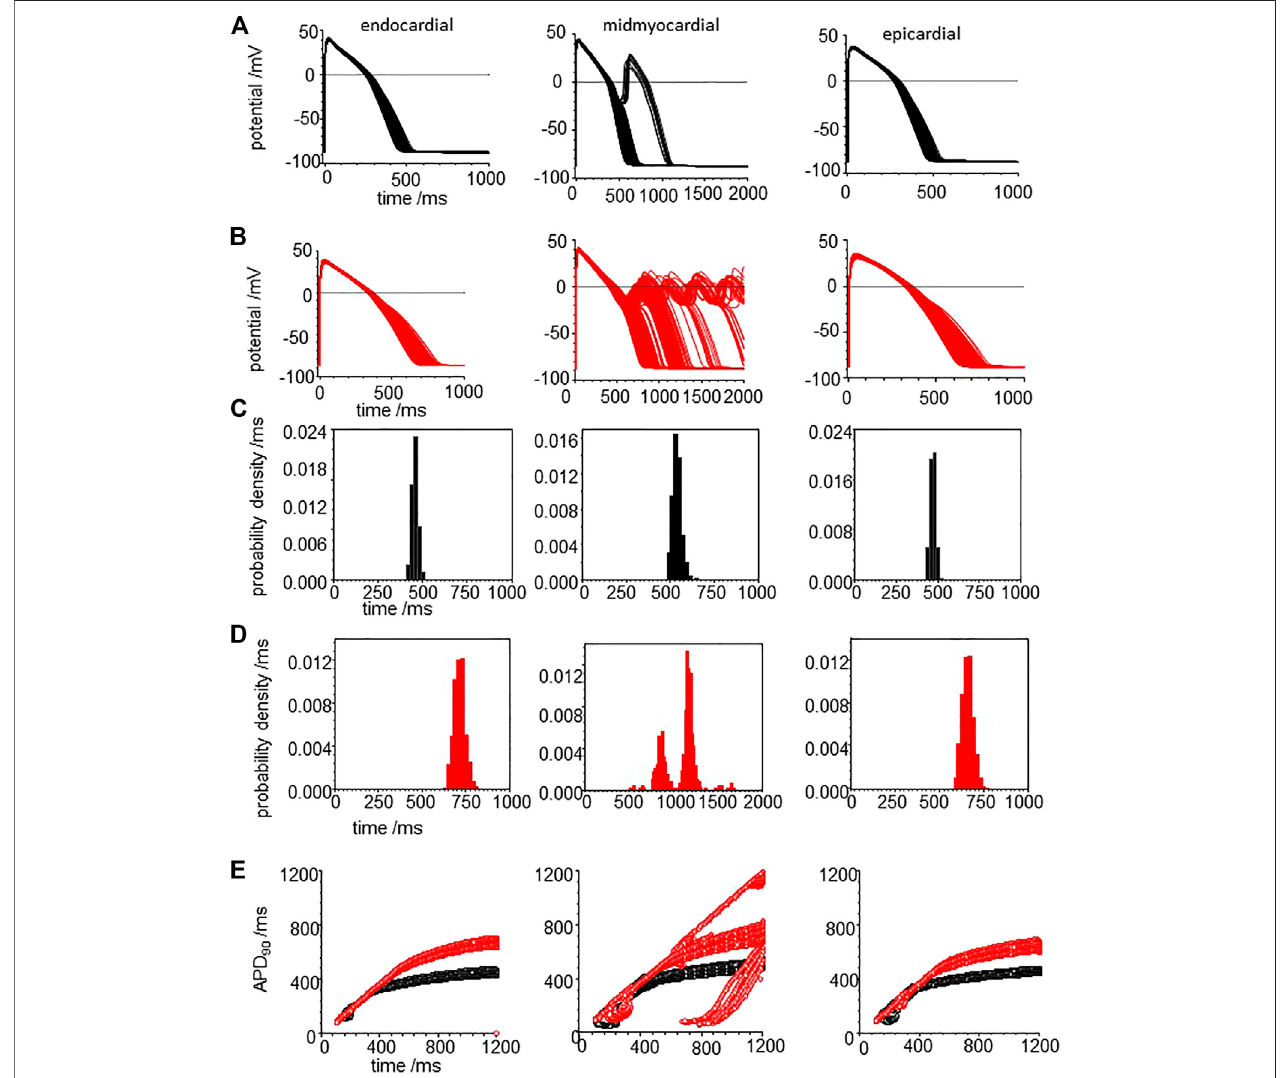
FIGURE 9 | CO prolongs APD90 and increases its variability in the heart failure human ventricular myocardial cell models. Action potentials for (A) heart failure models,withmeansoftheparametersfromElshrifetal.(2015)forheartfailureand (B) fortheeffectofCOontheheartfailuremodel.Allthecurrentmagnitudeparameters Gaussian distributed with a 5% standard deviation (C,D) . Probability density estimates for APD 90 ‘ s of action potentials of (C) standard model and (D) CO model. (E) 32 superimposed dynamic restitution curves for cell models, with the conductance parameters distributed as above. Red: with CO parameters, black standard